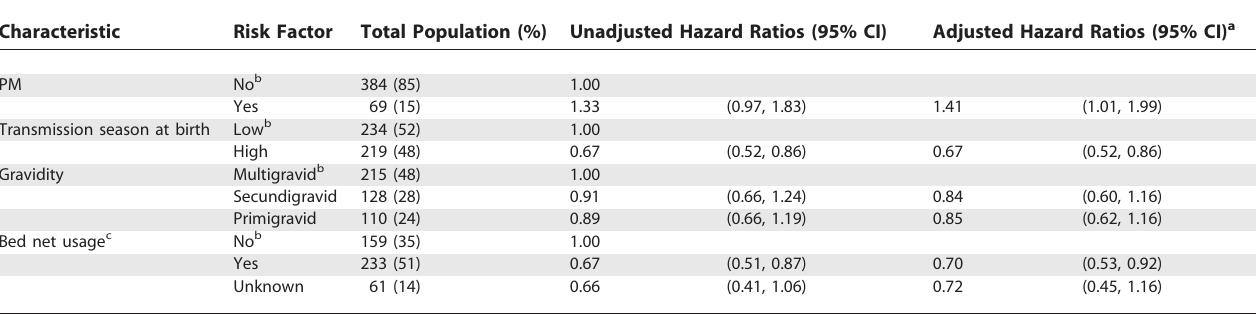
Table 2. Unadjusted and Adjusted Hazard Ratios for Risk of First Parasitemia during Infancy Characteristic